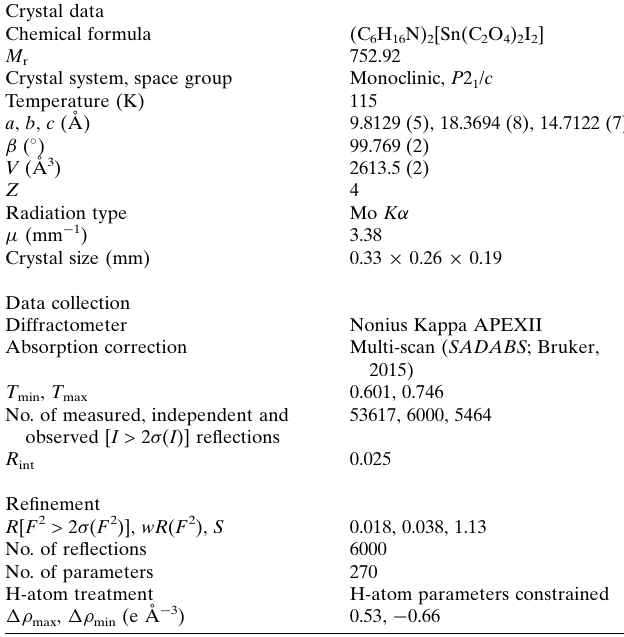
Table 2 Experimental details. Crystal data Chemical formula